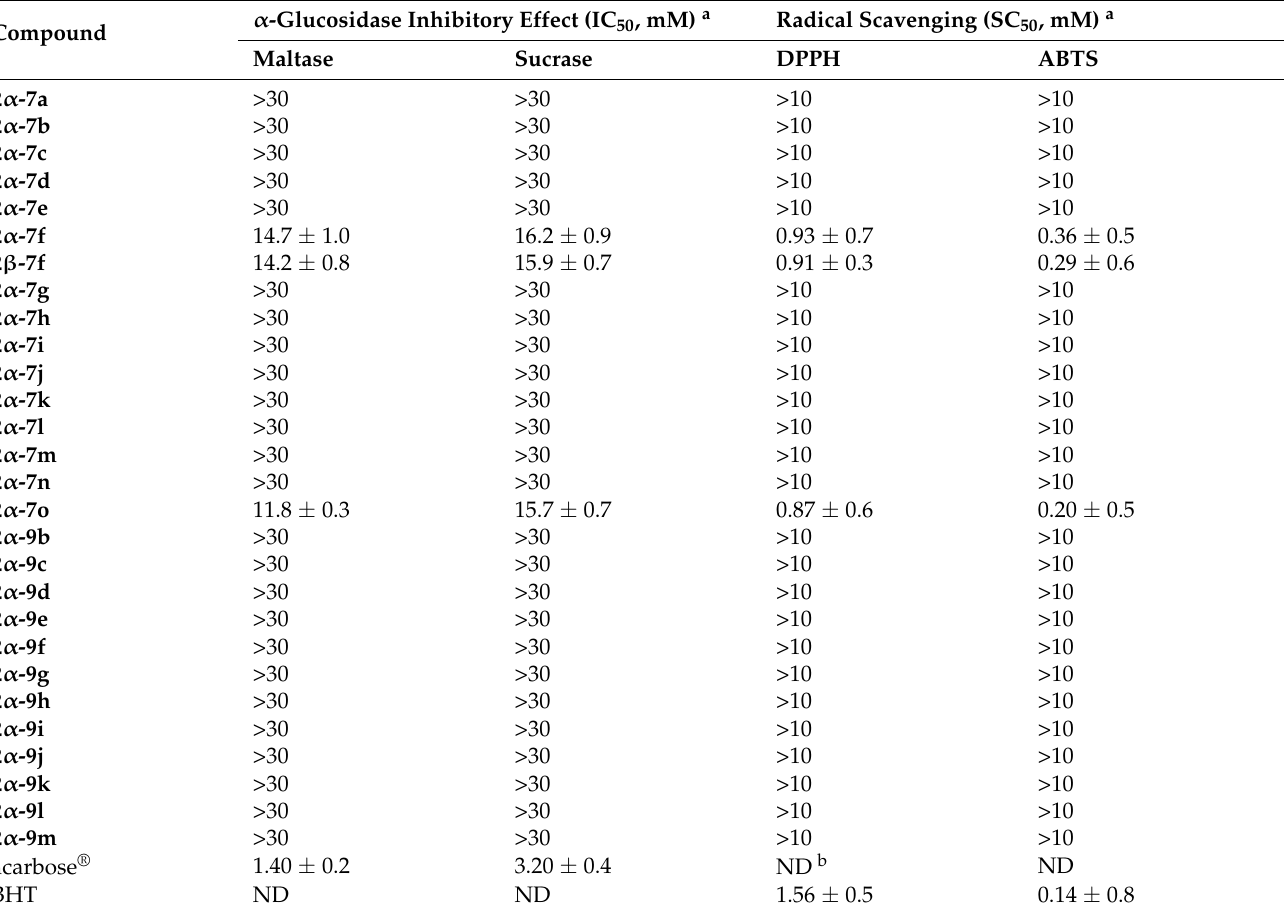
Table 3. α -Glucosidase inhibitory effect and radical scavenging activity of furofuran